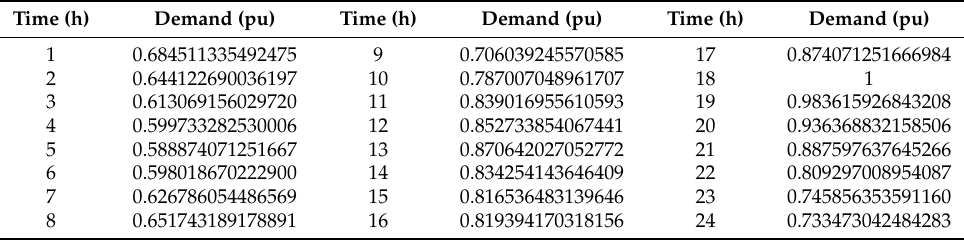
Table 15. Daily demand variation for the 33-bus